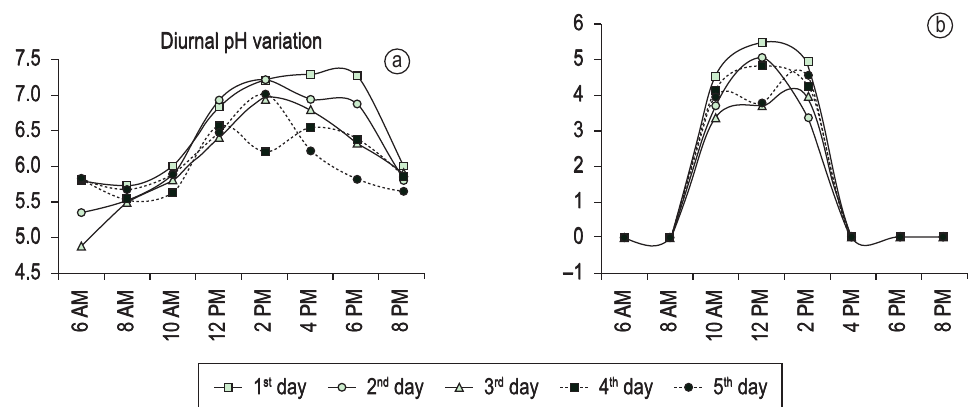
Figure 3. Diurnal pH and underwater radiation